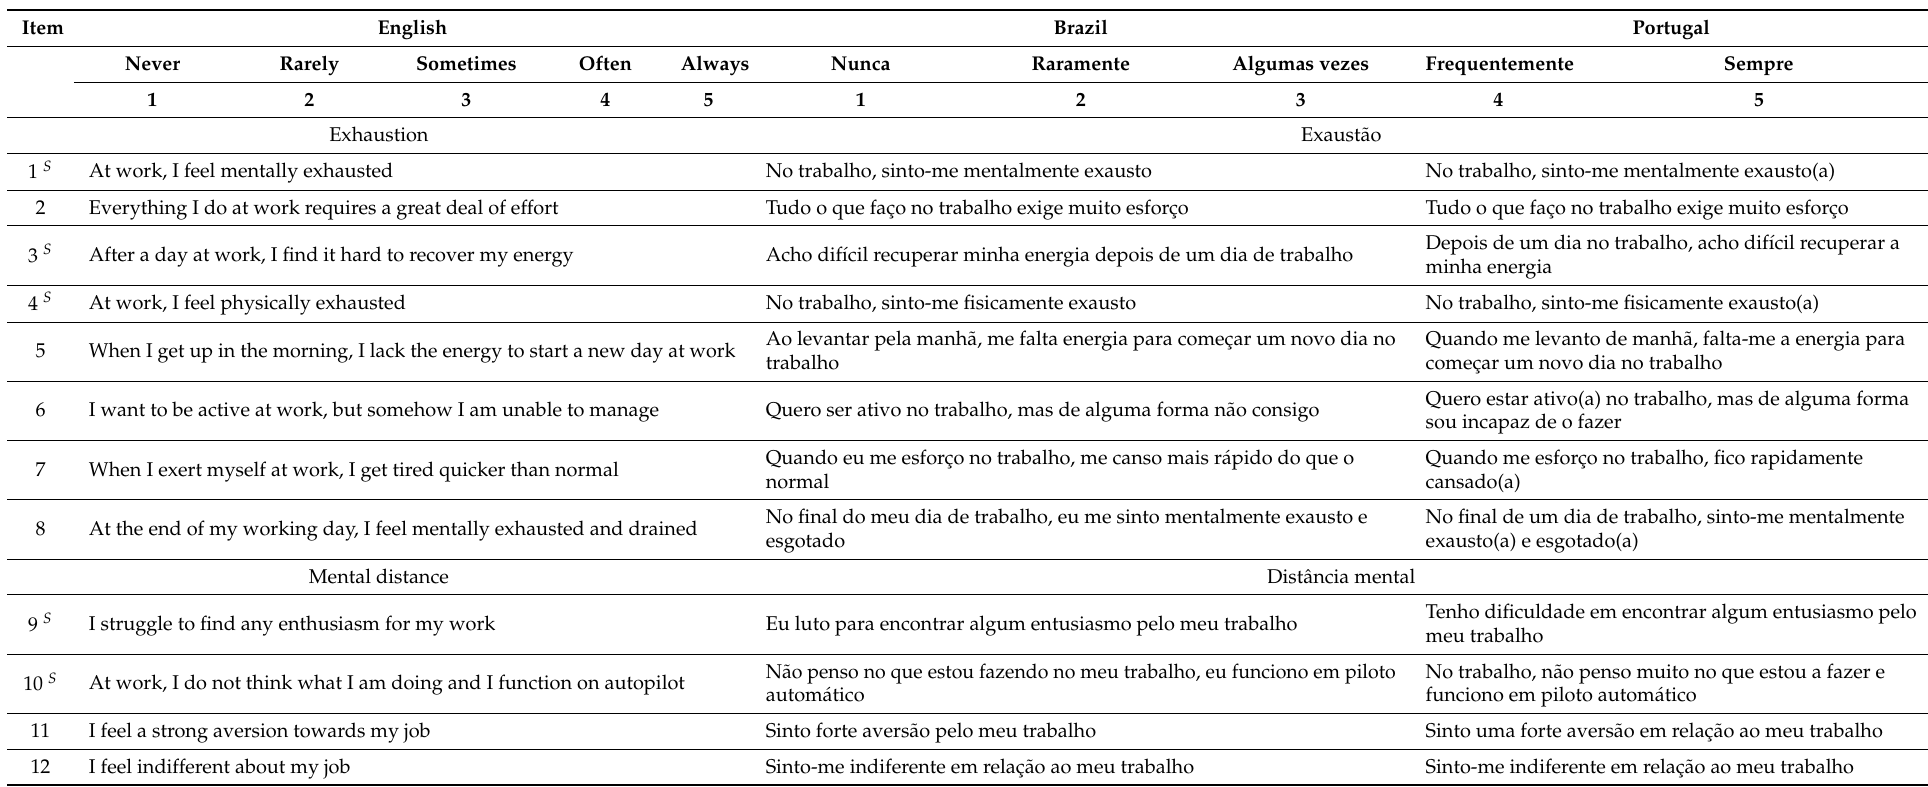
Table 1. BAT English, Brazilian, and Portuguese